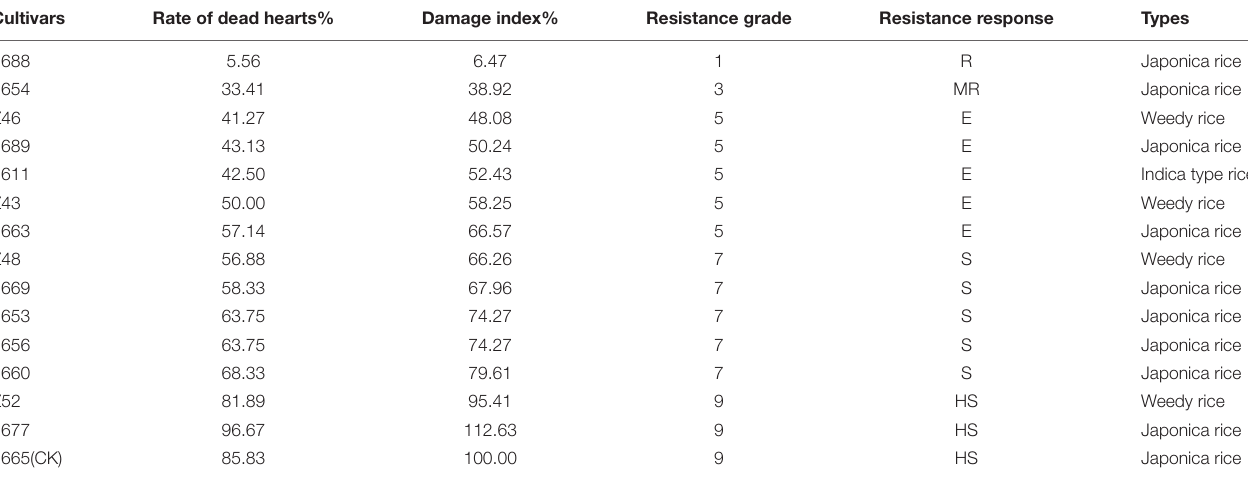
TABLE 4 | Identification result of rice resistance to SSB in greenhouse.